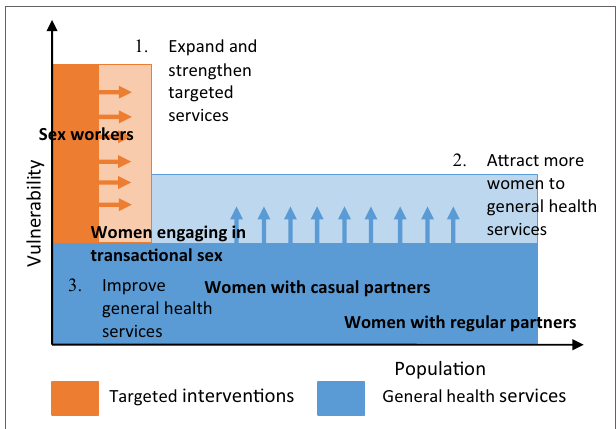
FigUre 1 | A “diagonal” approach to enhance access to health services for high-risk